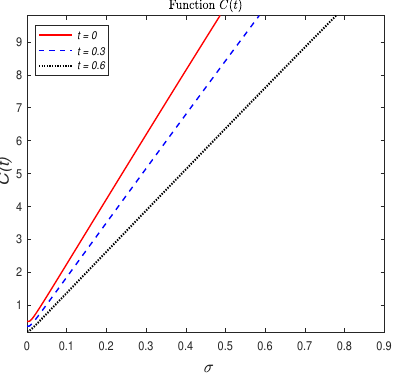
Figure 3. Time evolution of European call option price C ( t ) as a function of σ